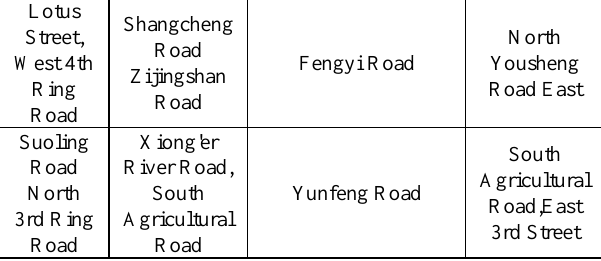
Table 1. Example of official classification data.